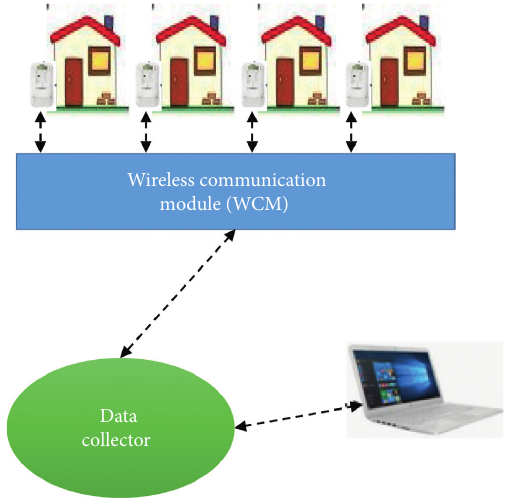
Figure 2: Data collection